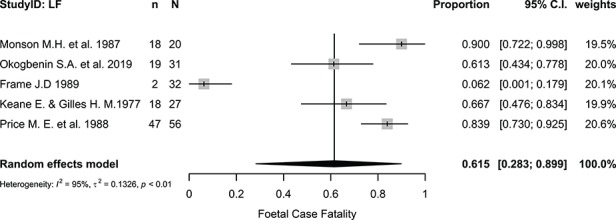
Proportional meta-analysis of studies reporting fetal loss from Lassa fever in pregnancy. I2, Higgins statistic, τ2, tau squared, p, p-value associated with Cochran's Q for heterogeneity; LF, Lassa fever; n, number of fetal losses; N, total number of fetuses included in the analysis.